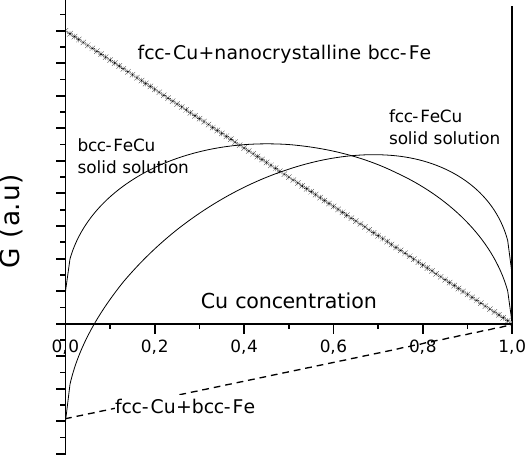
FIGURE 9. Diagram of the free energy curves for the Fe-Cu